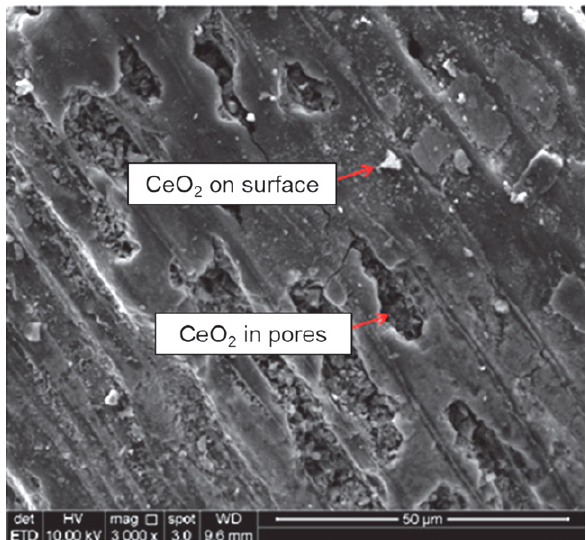
Figure 8. SEM image of CeO 2 /AC.